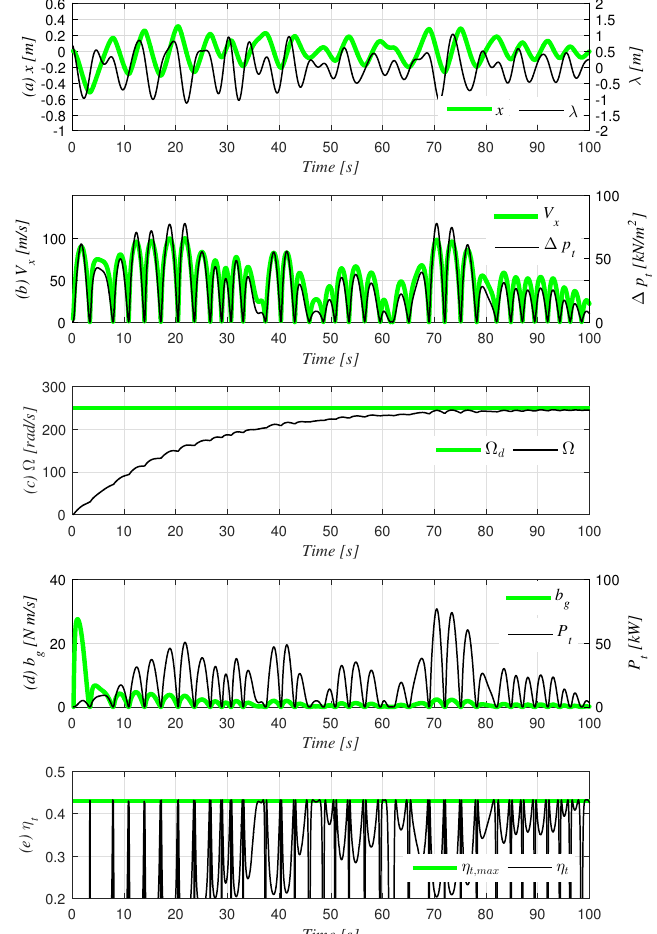
Figure 7. Simulation result of the first 100 s with the constant angular velocity (CAV) controller when Ω = 250 rad/s and k p = 0.05: ( a ) wave λ and water column positions x ; ( b ) airflow speed at the d turbine duct V x and pressure drop across the turbine ∆ p t ; ( c ) turbine rotor angular velocity Ω and its desired value Ω d ; ( d ) generator damping coefficient (control input) b g and power extraction from the turbine P t ; ( e ) turbine efficiency η t and its maximum value η t , max